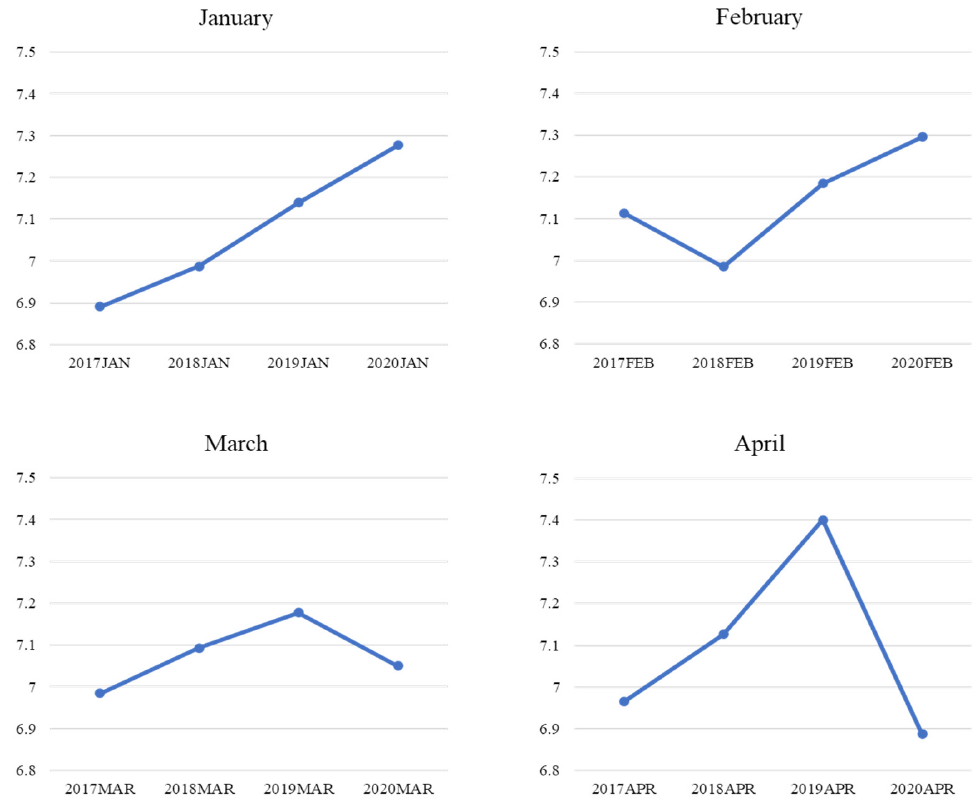
Figure 4. Mean comparison of positive sentiment by month.